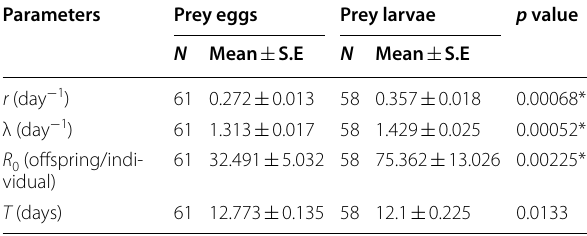
paired bootstrap test at the 5% significance level